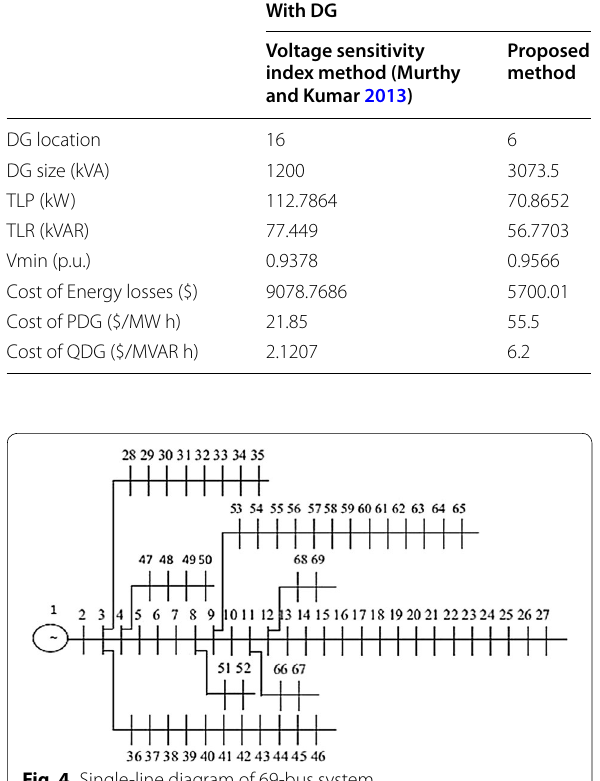
Table 6 Results for 33 bus system with DG at 0.9 pf